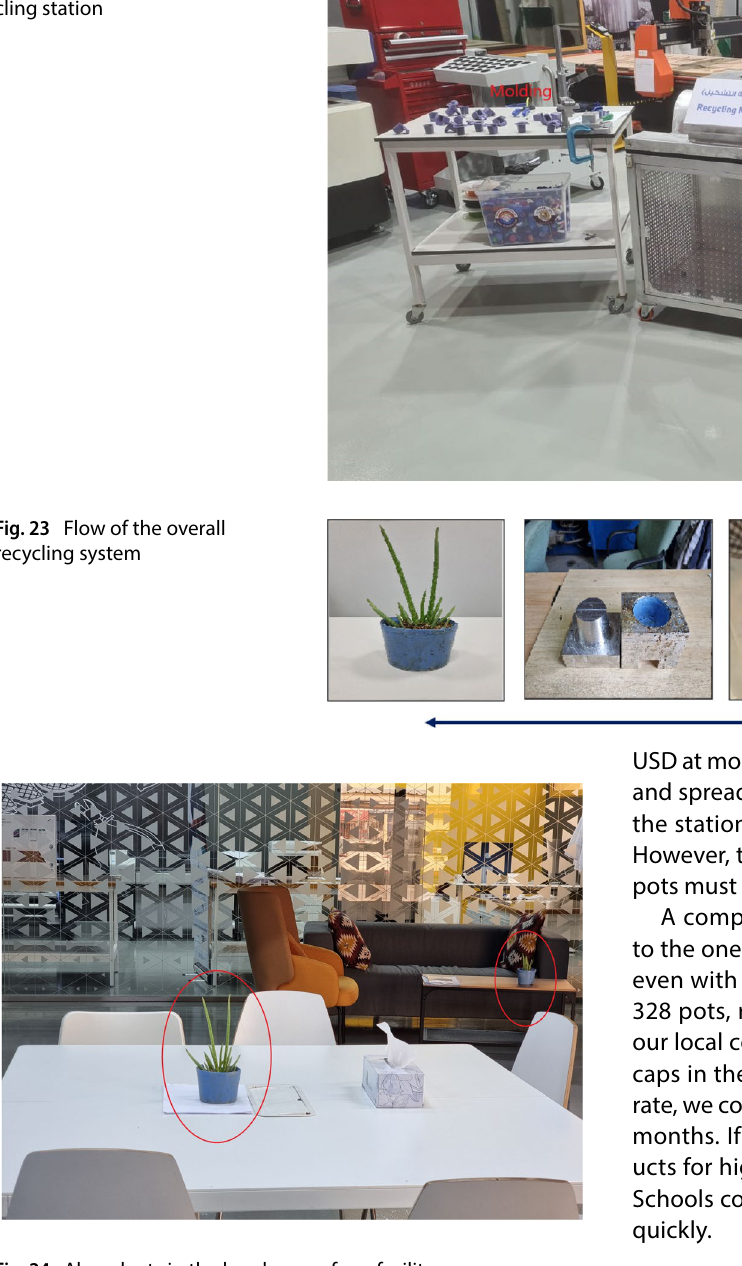
Fig. 24 Aloe plants in the break area of our